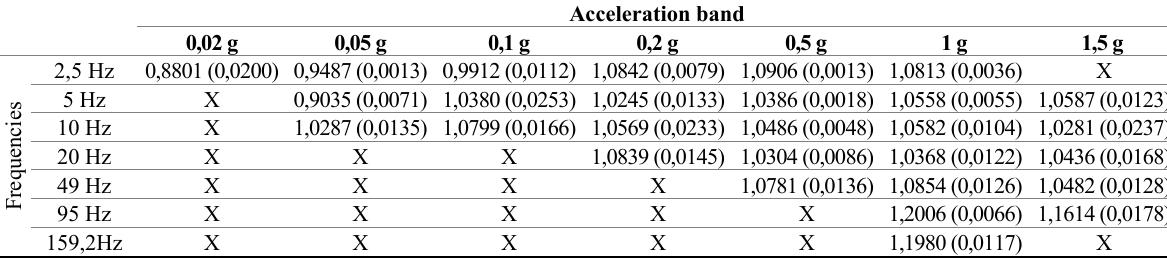
Table 5. Multiplication Factors for the MPU-6050 (average and standard-deviation